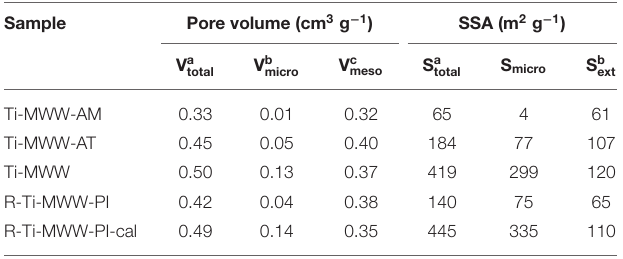
TABLE 3 | The physicochemical properties of Ti-MWW related catalysts. Sample